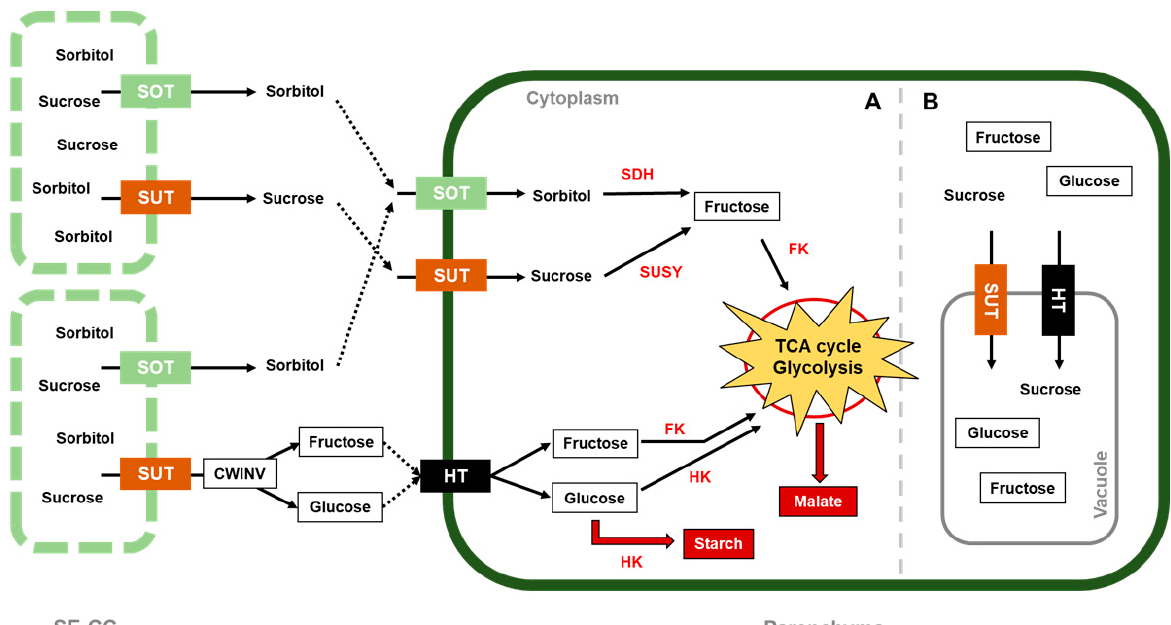
Figure 2. Sugar metabolism in apple. Sorbitol and sucrose are the photoassimilates unloaded to cell fruits via apoplasmic unloading from the sieve element–companion cell complex (SE-CC). With their respective cell-wall transporter, these com- pounds enter the parenchyma cell where they are converted into hexoses (fructose and glucose), which are phosphorylated by fructokinase and hexokinase, respectively, to enter glycolysis/TCA cycle, with the objective of satisfying the energetic requirements for apple growth. The cytoplasm is divided according to ( A ) high sugar metabolism that produces energy, starch for storage, and malate used to (re)fix the mitochondrial CO 2 via the malate-CO 2 shuttle, as well as for accumulation, and ( B ) slower sugar metabolism that starts to accumulate sucrose, fructose, and glucose inside the vacuoles. In red letters, the enzymes are abbreviated as follows: SDH, sorbitol dehydrogenase; SUSY, sucrose synthase; FK, fructokinase; HK, hexokinase. Sugar transporters are abbreviated as follows: SOT, sorbitol transporter; SUT, sucrose transporter; HT, hexose transporter. Table 2. Primary metabolites analyzed using different techniques. This table is based on the most recent resources with the highest amounts of metabolites quantified in the same experiment. G6P,